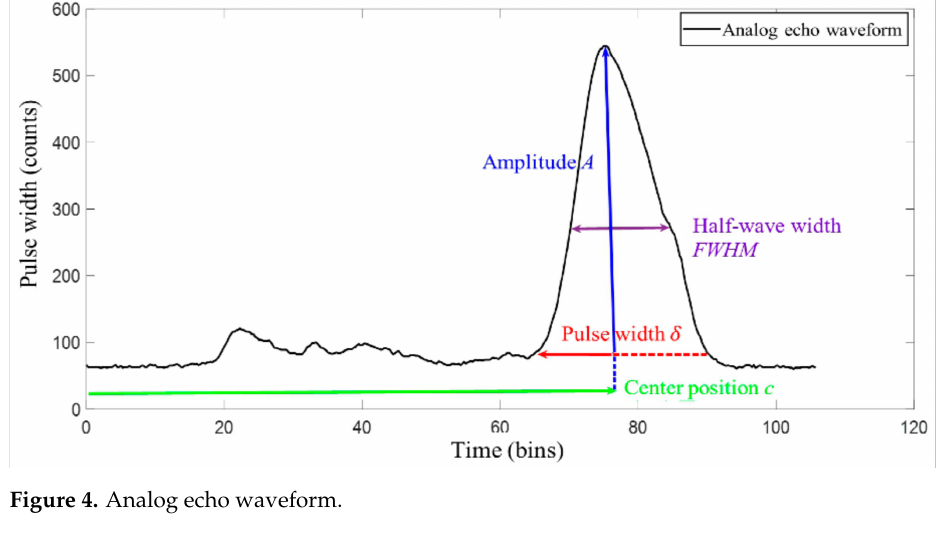
Figure 4. Analog echo